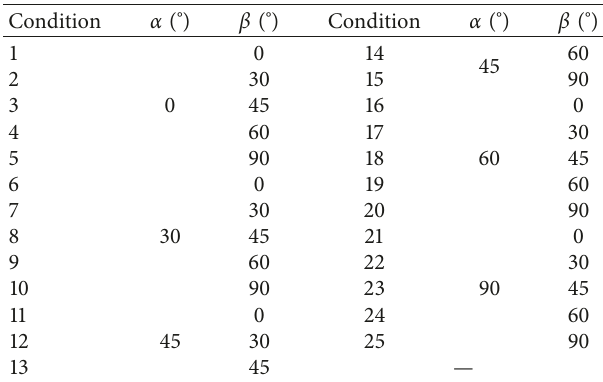
Table 3: Simulation test